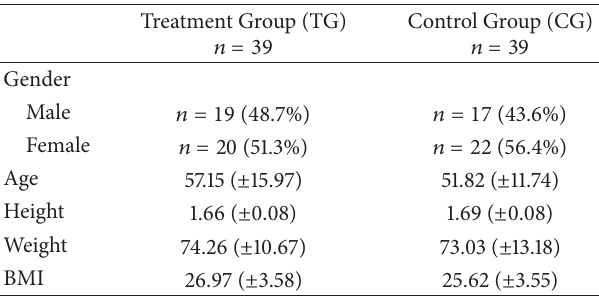
Table 1: Demographic and anthropometric characteristics of the participants.